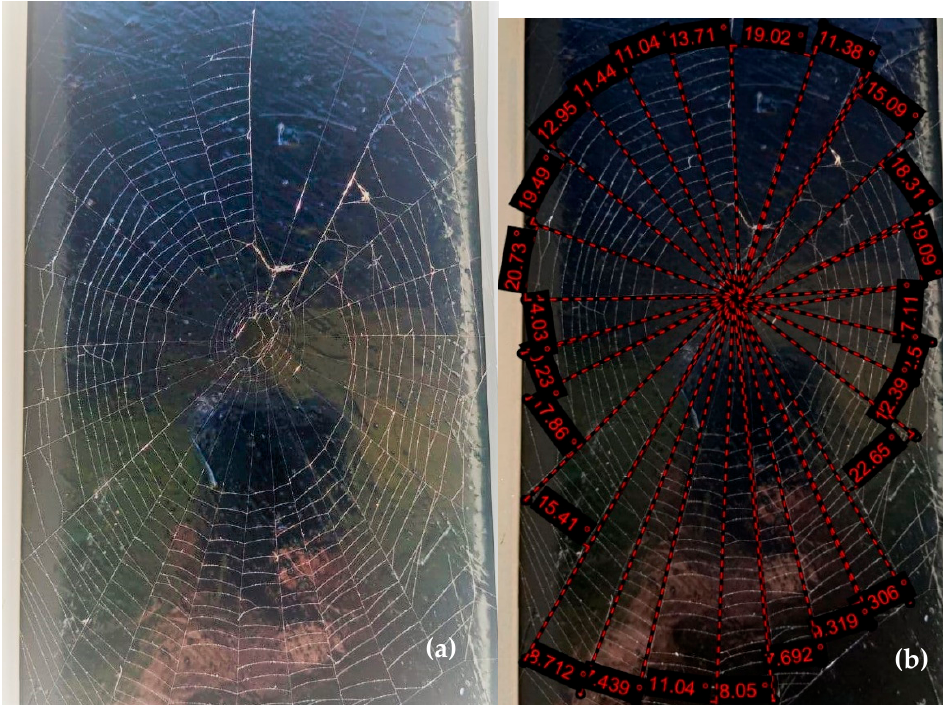
Figure 2. ( a ) Unmeasured image ( b ) measured image of SP1.